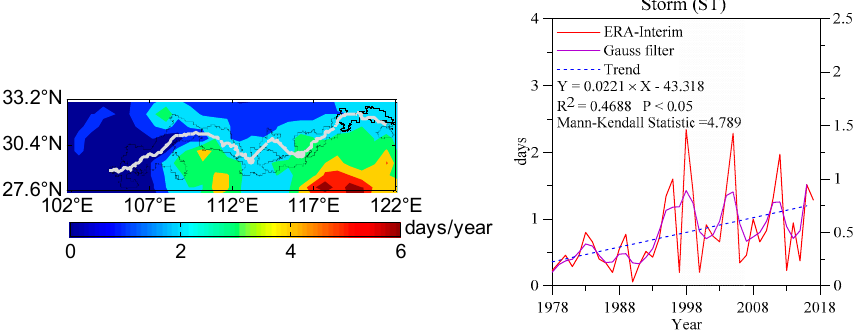
Figure 10. Average number of days per year with the storm (the gray area indicates a more significant variability) during the period 1979–2017 based on ERA ‐ Interim Reanalysis data.